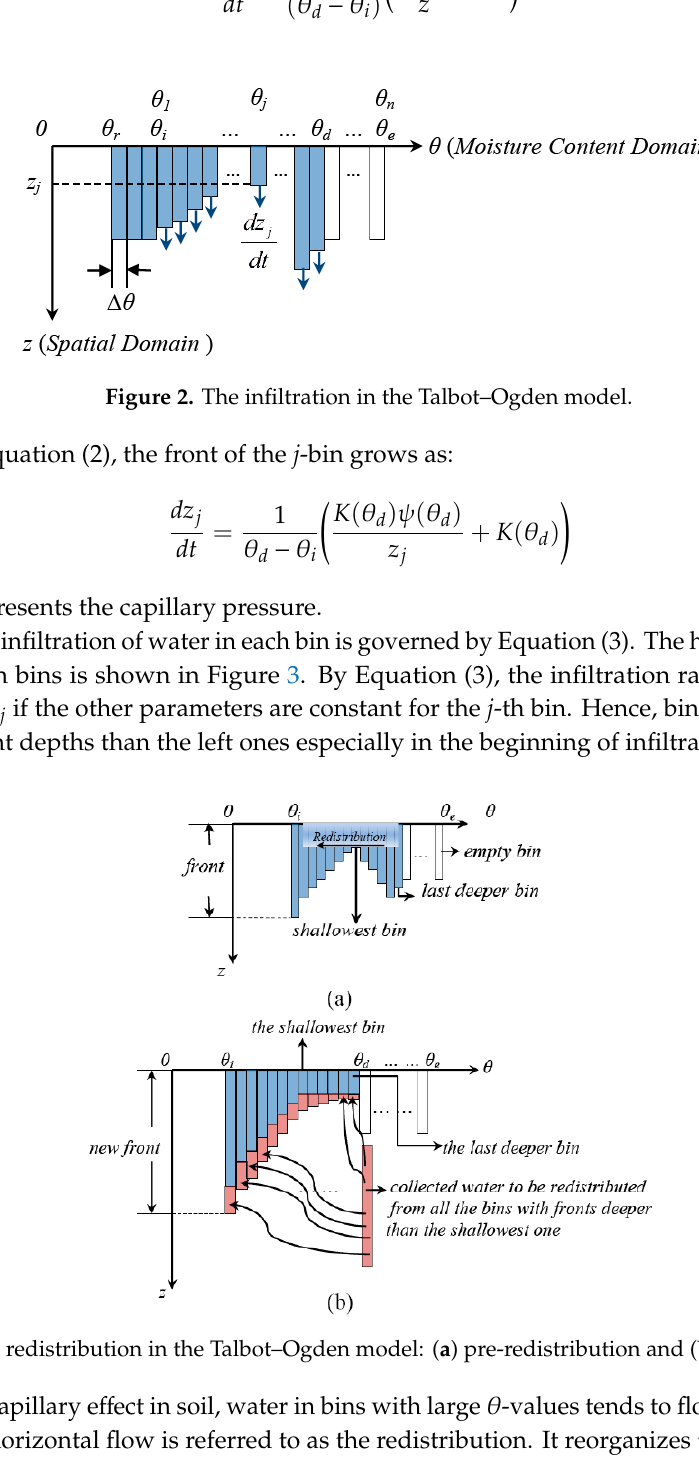
Figure 3. The redistribution in the Talbot–Ogden model: ( a ) pre-redistribution and ( b ) post-